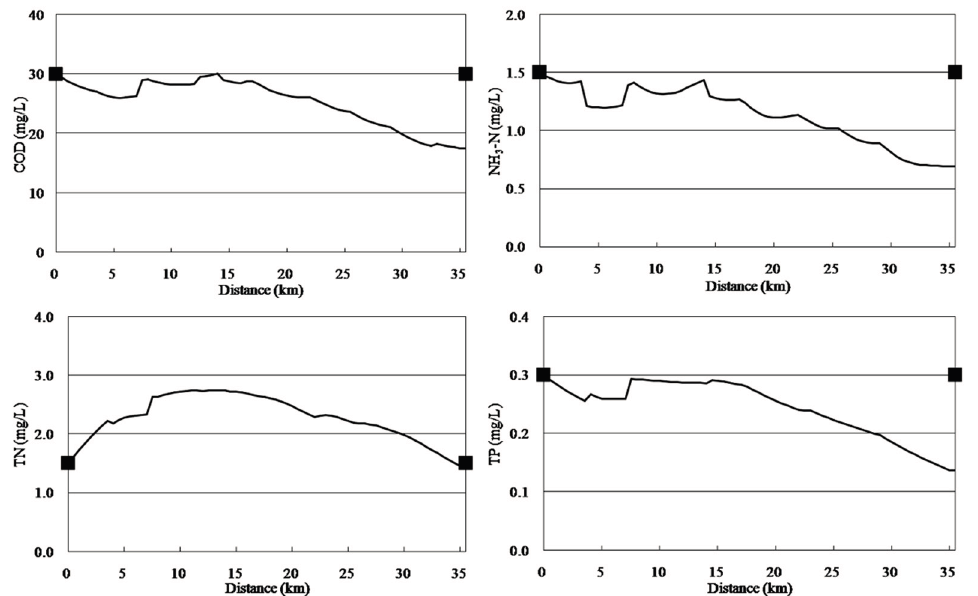
Figure 5. Simulation curves from implementing point source and non-point source simultaneous reductions of 58.77%.